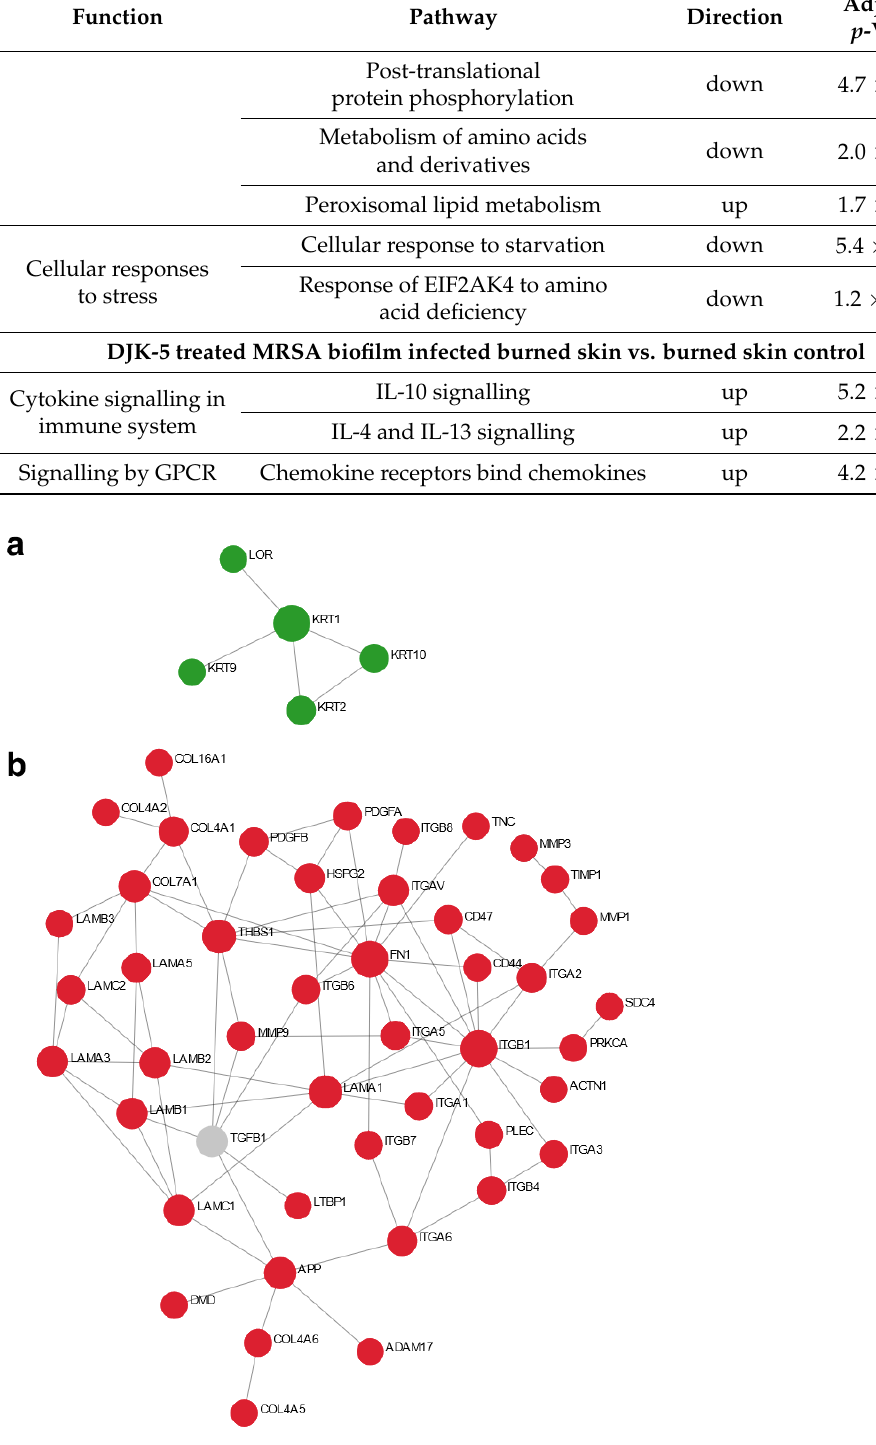
Figure 2. NetworkAnalyst depiction of modulation of skin barrier function and extracellular matrix turnover by MRSA biofilm infection in thermally-injured skin. Minimum protein–protein interaction networks of cornified envelope formation ( a ) and extracellular matrix organization ( b ) comparing MRSA biofilm infected skin with burned skin control using NetworkAnalyst. Red nodes denote upregulation. Green nodes denote downregulation.